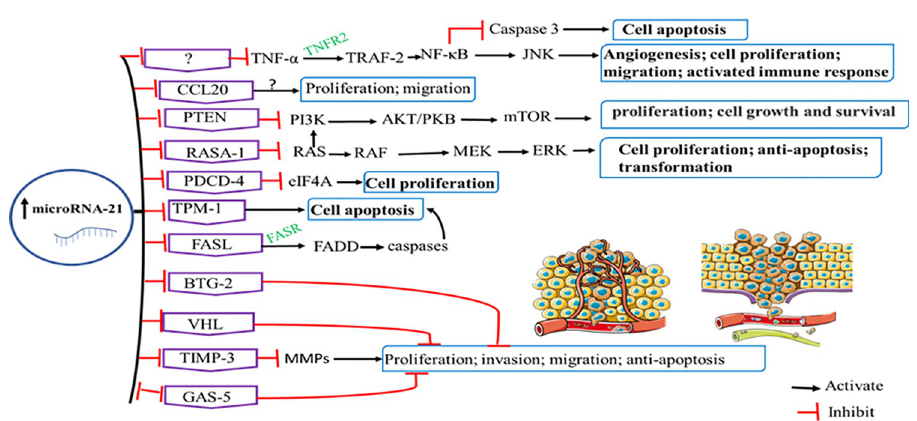
Fig 3. The role of microRNA-21 in the cancer progression via different signaling pathways. TNF- α : tumor necrosis factor α ; TNFR: tumor necrosis factor receptor; CCL20: chemokine ligand 20; TRAF-2: TNF receptor-associated factor 2; NF-KB: nuclear factor κ B; JNK: c-Jun N-terminal kinase; PTEN: phosphatase and tensin homolog; PI3K: phosphoinositide 3-kinase; AKT/PKB: Akt/protein kinase B; mTOR: mammalian target of rapamycin; RASA-1: